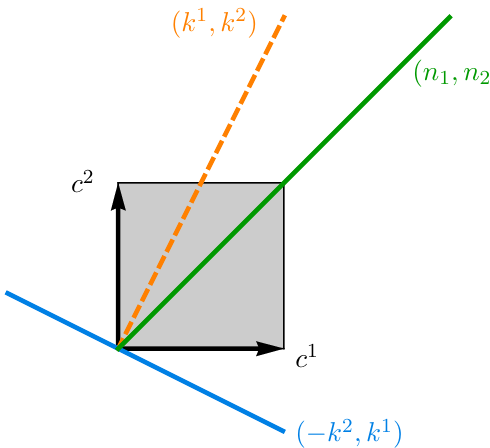
Figure 2 . Axion moduli space for two axions ( c 1 ; c 2 ) with the orbit under the U(1)-St(cid:127)uckelberg gauging indicated through the orange, dashed line. The blue line represents the orthogonal direction to the St(cid:127)uckelberg axion, while the green line indicates the axionic direction coupled to the non- Abelian gauge